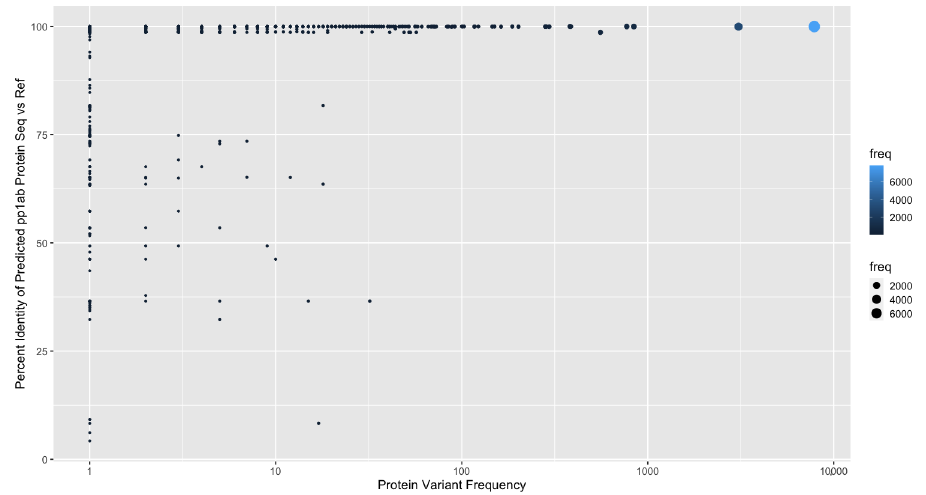
Figure 4. For Replicase polyprotein 1ab, the protein sequence variant frequency and protein se- quence similarity of our predicted sequence to the known UniProt ID: P0DTD1 references is shown. The frequency of each protein variant is indicated by color and point size.